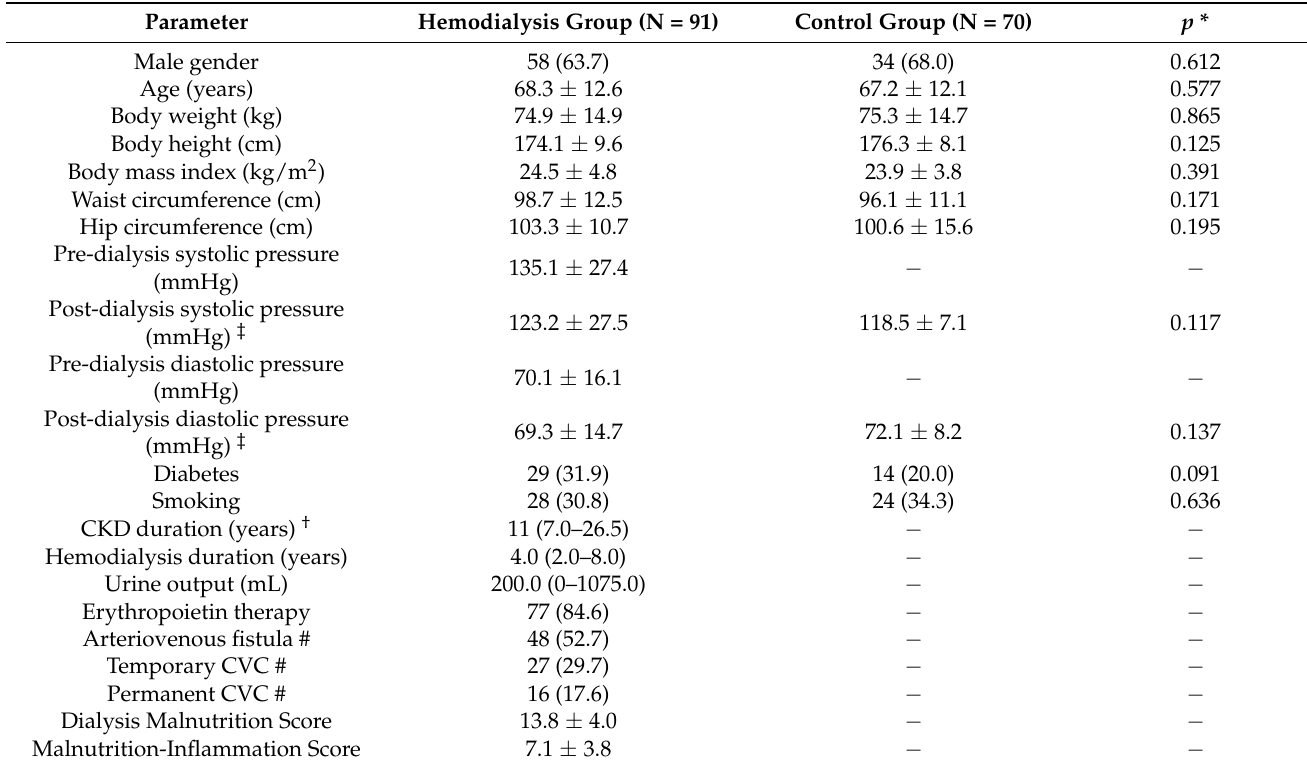
Table 1. Baseline parameters of the study